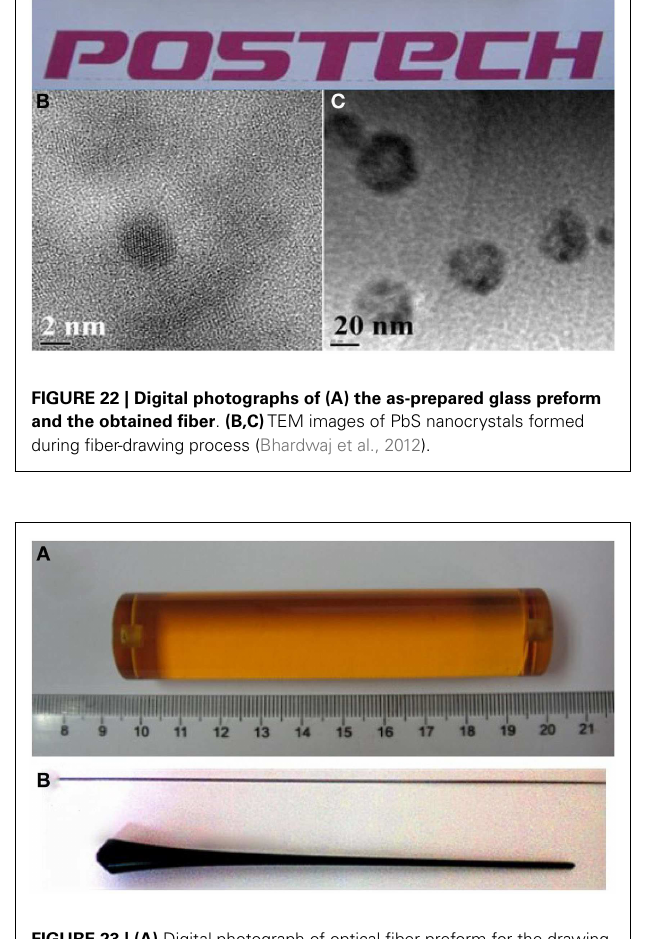
FIGURE 23 | (A) Digital photograph of optical fiber preform for the drawing of PbS QD-doped glass fiber. (B) Digital photograph of glass preform tail after fiber-drawing